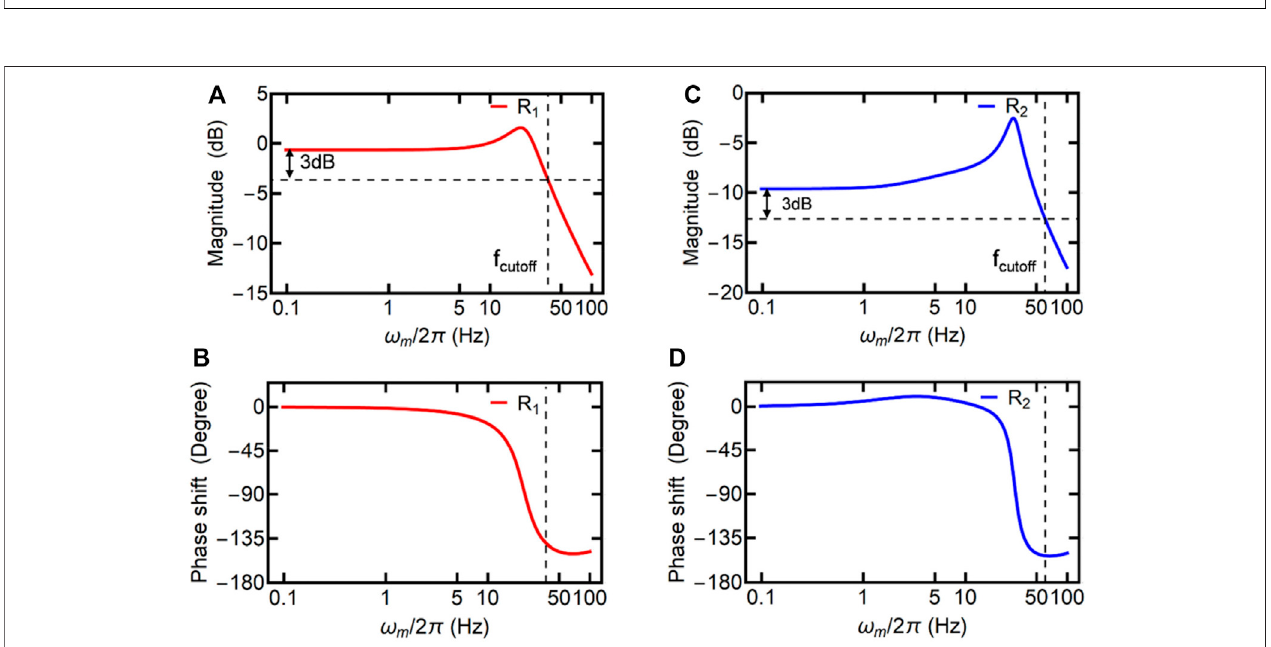
FIGURE 3 | (A) The magnitude and (B) the phase shift of the response function R 1 as a function of ω m . (C) The magnitude and (D) the phase shift of the response function R 2 as a function of ω m . The dashed lines are used to indicate the cutoff frequency. The parameters for the theoretical simulations are Λ = ‒ 2 π ×15 Hz, γ 1 = 2 π ×6 Hz, and γ 2 = 2 π ×12